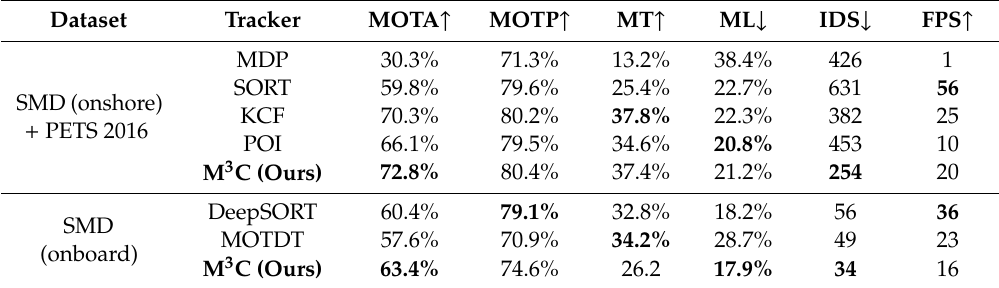
Table 2. Quantitative evaluation of di ff erent trackers on the two maritime datasets. We treated PETS 2016 as the onshore dataset considering a stationary large ship.